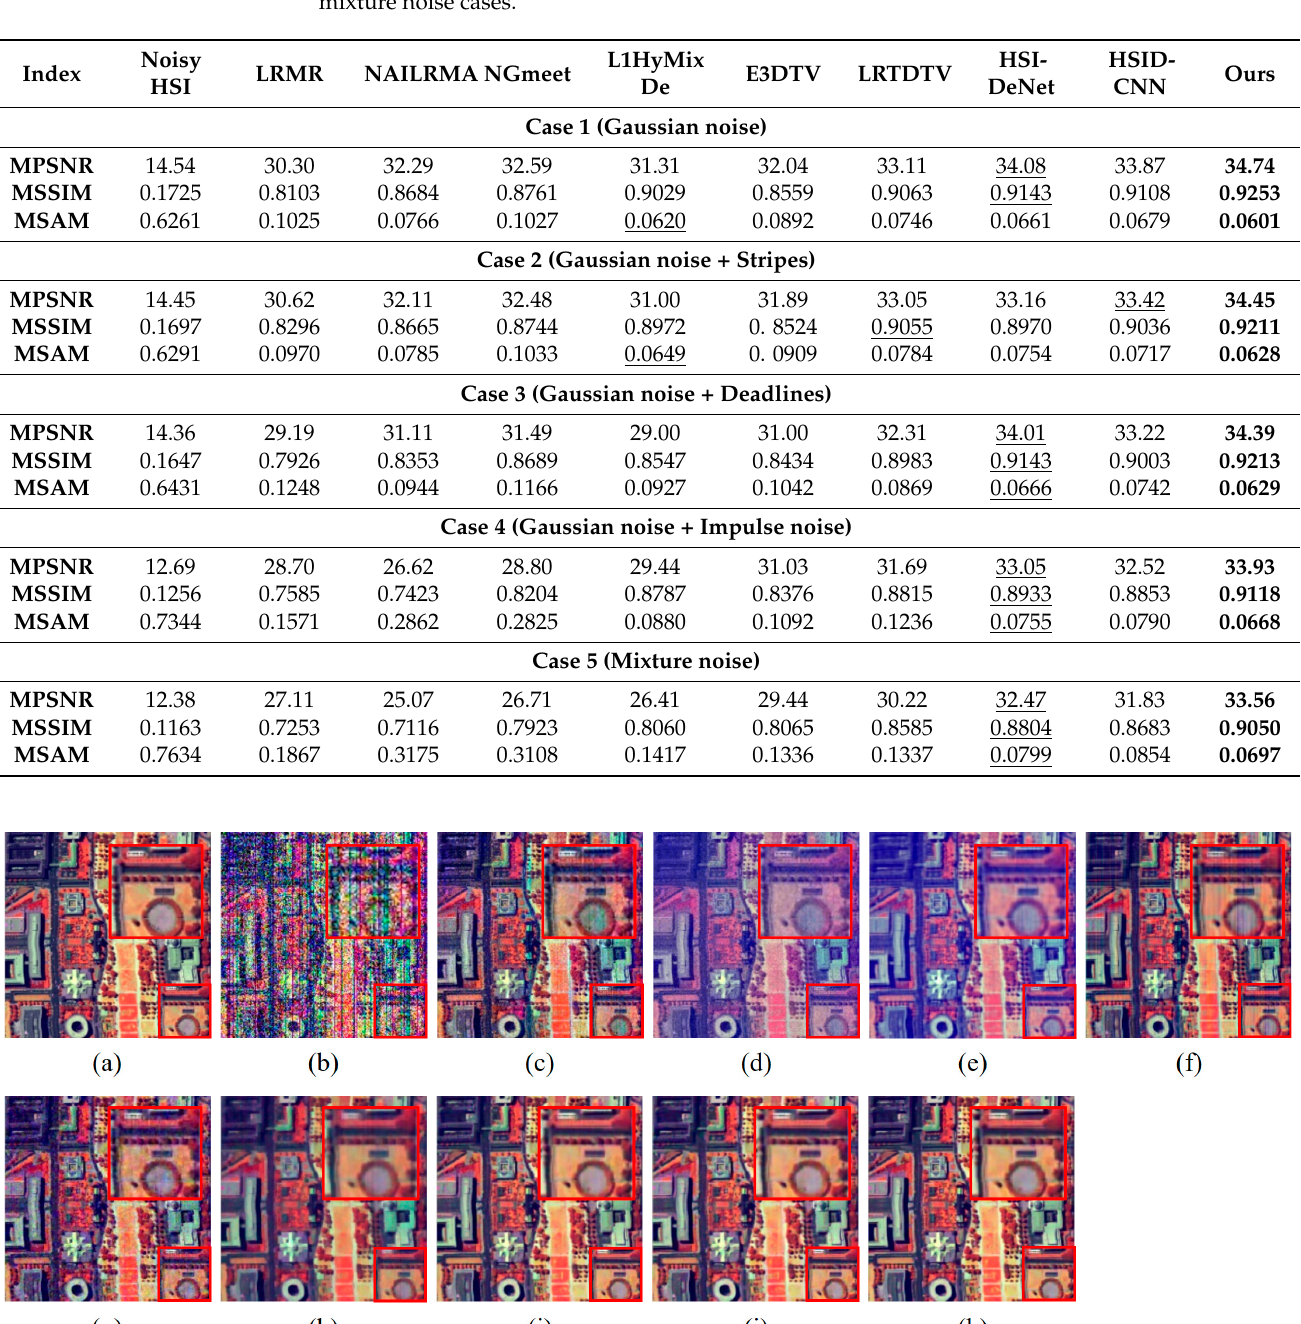
Figure 7. False color images synthesized with band 14, 24 and 54 of the denoised Pavia Center data in mixture noise case. ( a ) Clean; ( b ) noisy; ( c ) LRMR; ( d ) NAILRMA; ( e ) NGmeet; ( f ) L1HyMixDe; ( g ) E3DTV; ( h ) LRTDTV; ( i ) HSI-DeNet; ( j ) HSID-CNN; ( k ) ours.